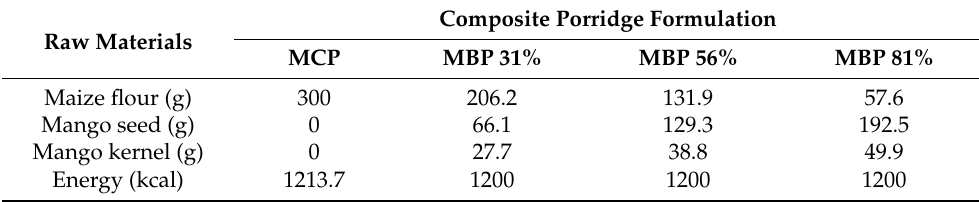
Table 1. Formulations of the composite porridges (g per 300 g wt).